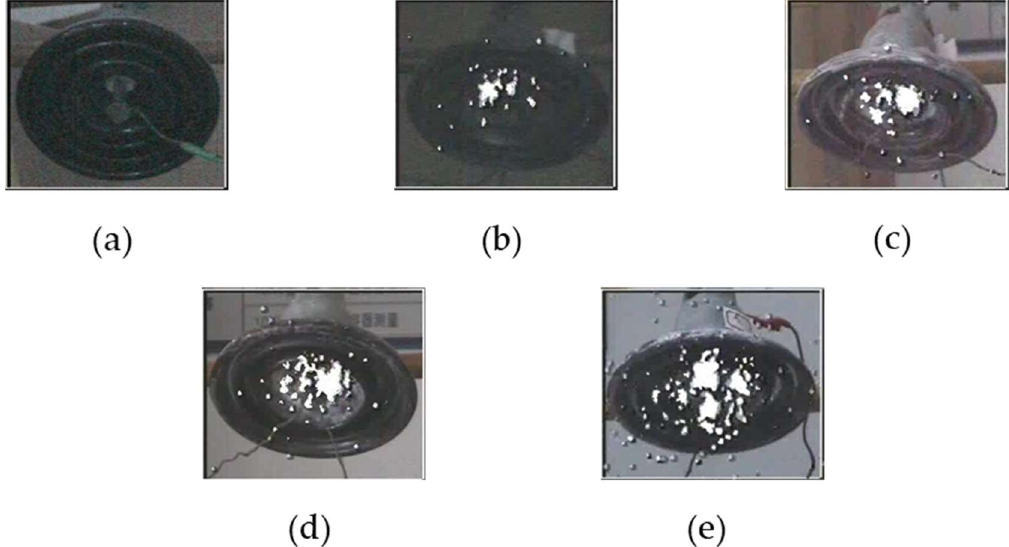
Figure 3. Ultraviolet images of a wet contaminated insulator. ( a ) Clean insulator; ( b ) Insulator of contamination grade Ⅰ ; ( c ) Insulator of contamination grade Ⅱ ; ( d ) Insulator of contamination grade Ⅲ ; and ( e ) Insulator of contamination grade Ⅳ .